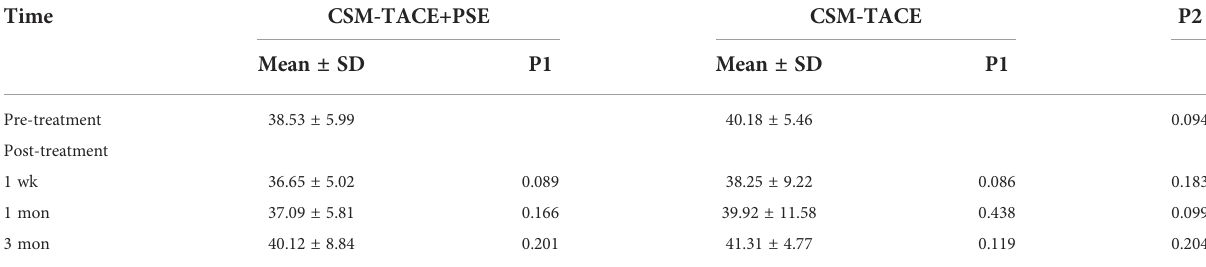
TABLE 7 Follow-up results of albumin (ALB) counts (g/L). Time